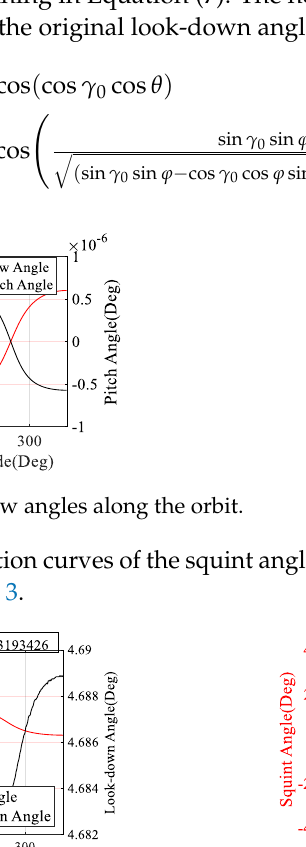
( b ) Figure 4. Variations of the RLS during the synthetic aperture time. ( a ) The eccentricity is 10 − 8 ; ( b ) the eccentricity is 0.01. As shown in Figure 4, the fluctuation scope of the squint angle is larger, which can reach tens of degrees during the synthetic aperture time. Furthermore, with the increase of the eccentricity, the variation of the look-down angle within the synthetic aperture time is greater. The look-down angle and the squint angle correspond to each other. Only when both of them have appropriate angles can the Doppler centroid be zero. It can be seen that even small fluctuation of the look-down angle plays a very significant role. Therefore, the variation of Doppler parameters caused by the real-time variation of the two must be fully considered within the synthetic aperture time. The following is an accurate analysis of Doppler parameters.